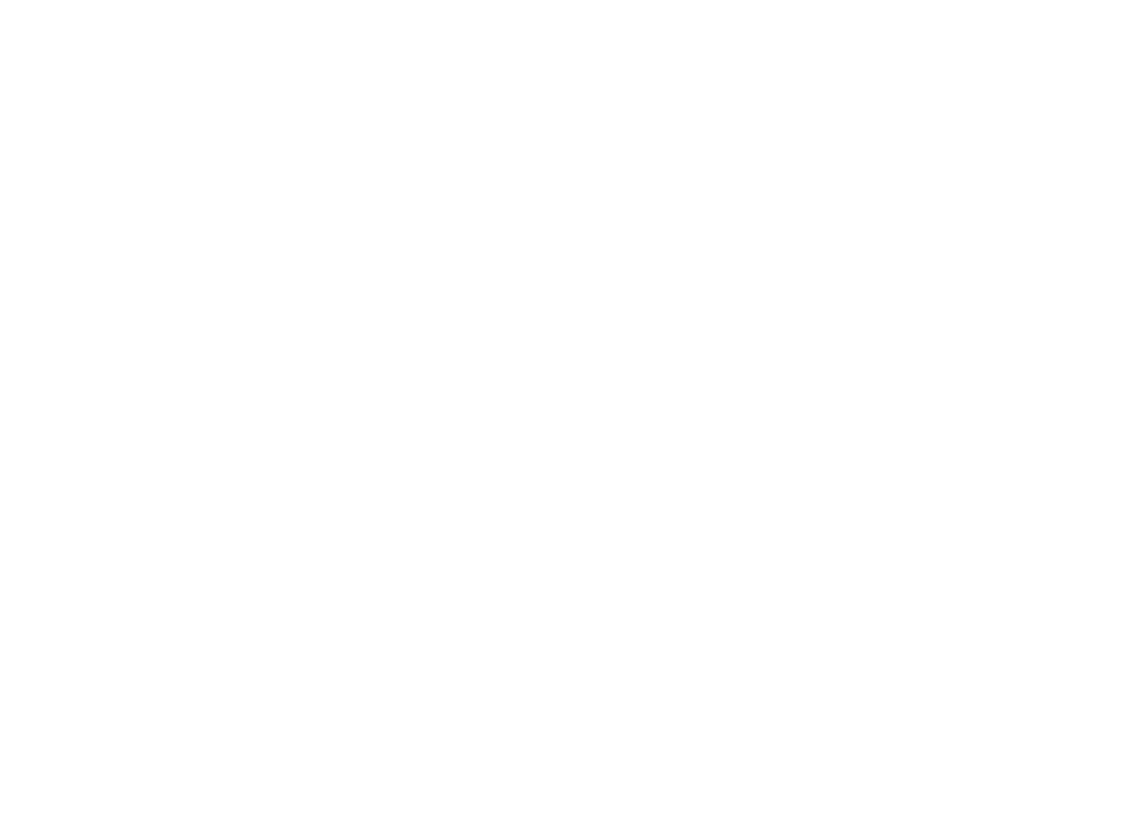
Utility degree of the alternative